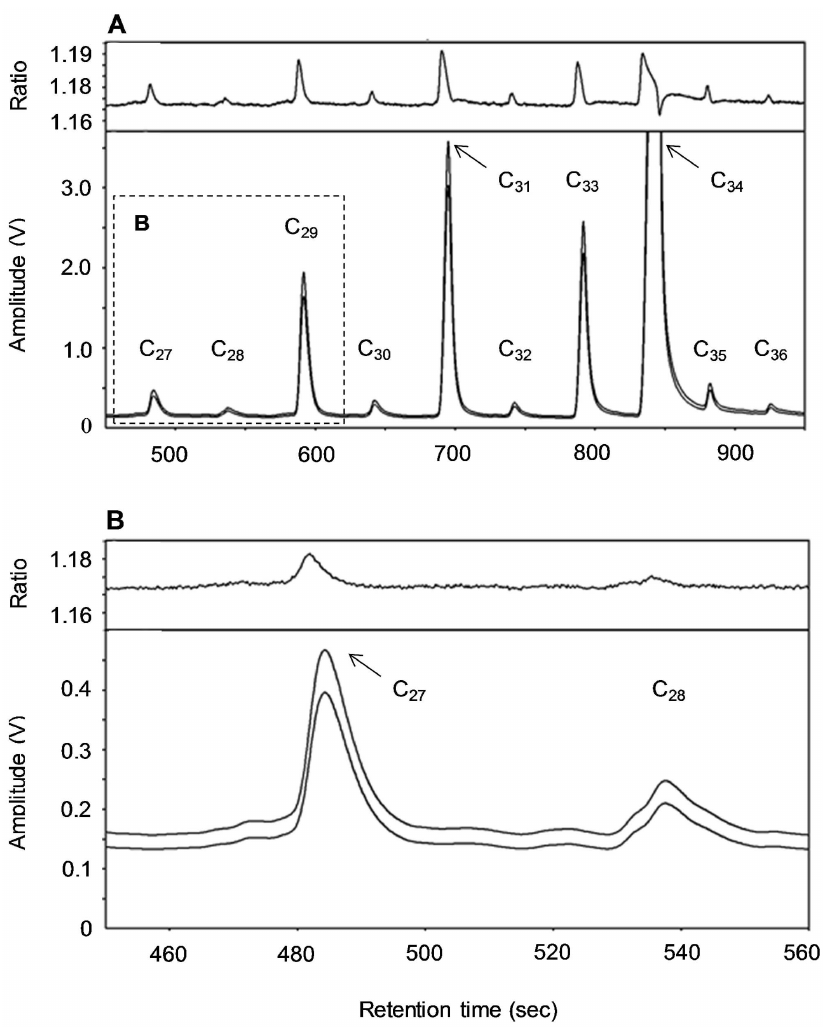
Figure 1. Mass spectra for d 13 C labeled n -alkanes (C 27 to C 36 ) collected in feces upon an intraruminal pulse dose. Plots A–B show mass chromatograms with signal amplitude voltage (V; lower plot segments) of individual n -alkanes for the carbon isotopes 12 C and 13 C (from lowest to highest concentration, respectively), and their respective 13 C: 12 C ratio (upper plot segments). C 34 is the internal standard. Mass spectra illustrate the distinctive peaks of the most abundant n -alkanes C 29 , C 31 and C 33 originating from a highly enriched fecal sample collected at peak concentration time (mean d 13 C 2 28.84; SEM 1.736). Although signals were detected and distinctive peaks were identified for lesser abundant n -alkanes (plot A), the 13 C: 12 C ratio indicates that the respective d 13 C levels were below or close to quantitation limit (0.3 V; plot B). Lower enriched fecal samples often provided no response signal for lesser abundant n -alkanes. Test samples were pre-concentrated by reducing the amount of solvent to 125 m L, and were injected at a split ratio 1:5 using a split/splitless-type injector operating on split mode to obtain a high peak